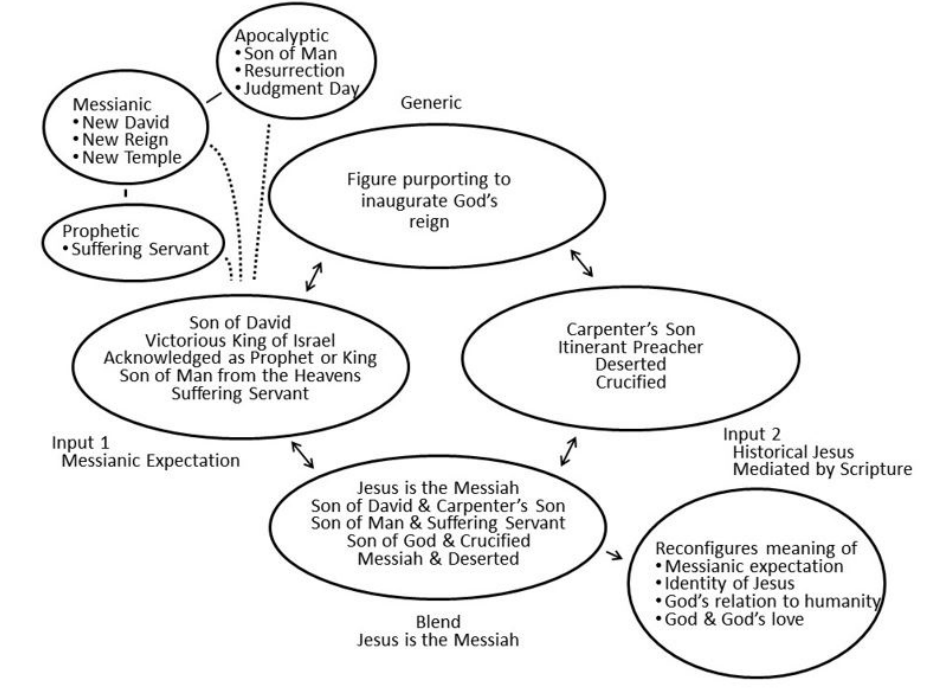
Figure 5: Jesus is Messiah